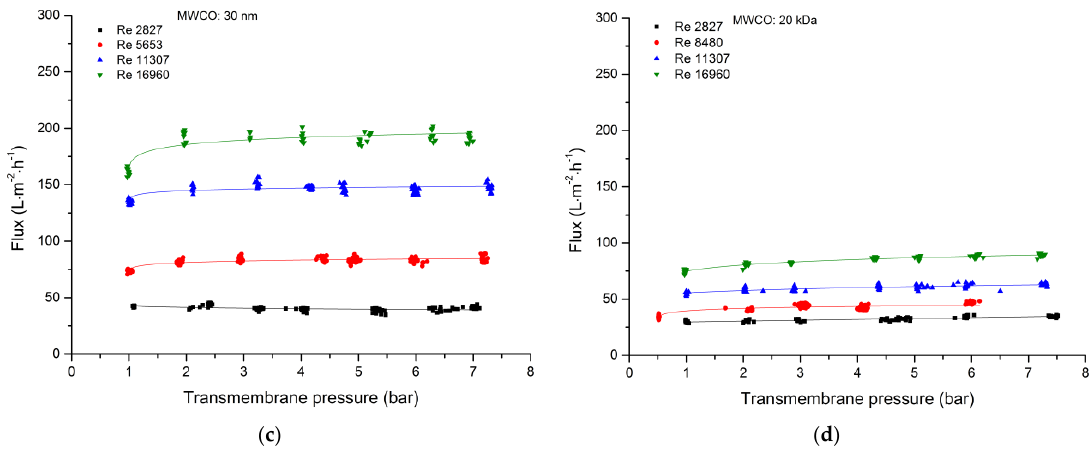
Figure 2. The steady state permeate flux is dependent on the transmembrane pressure of spent sulfite liquor during filtration at different Reynolds numbers. ( a ) 3-nm ceramic hollow fiber membrane. ( b ) 8-nm ceramic hollow fiber membrane. ( c ) 30-nm ceramic hollow fiber membrane. ( d ) 20-kDa tubular ceramic membrane.